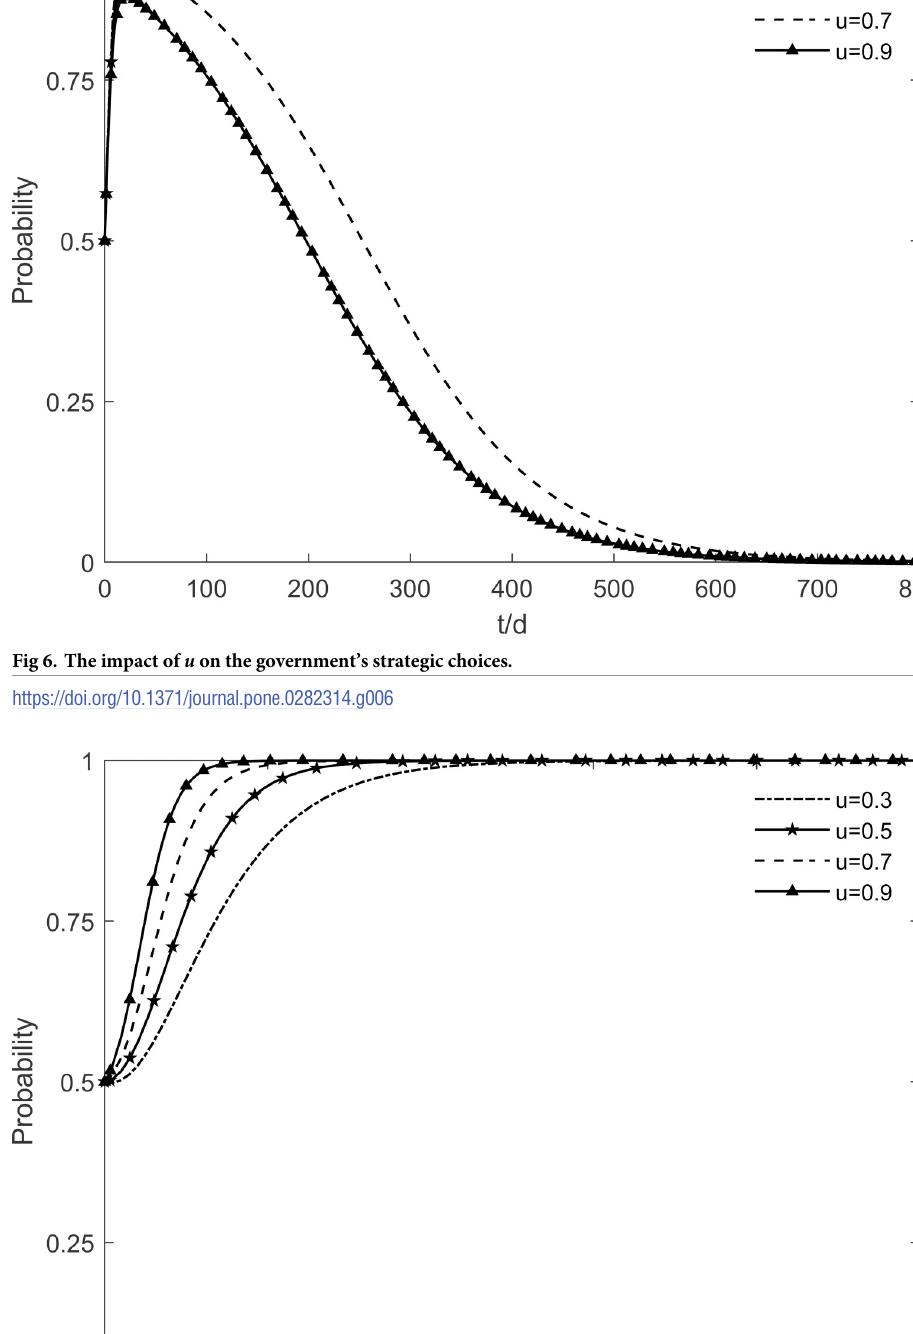
PLOS ONE | https://doi.org/10.1371/journal.pone.0282314 March 16,